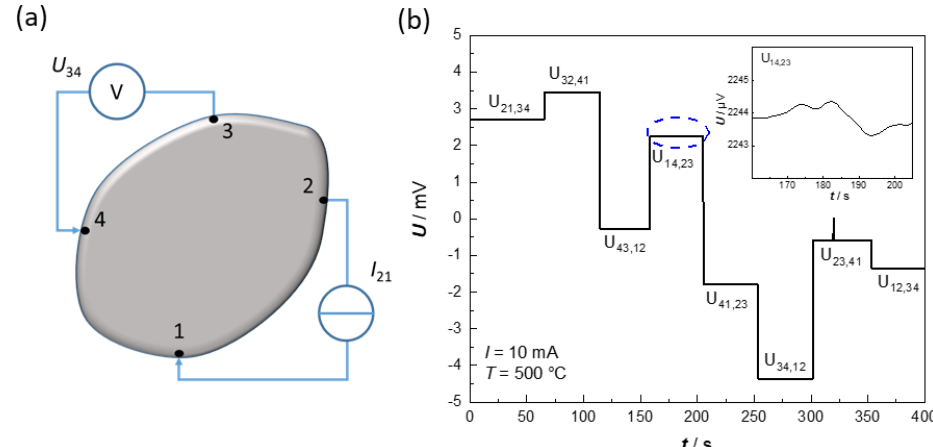
Figure 8. Measurement of the electrical conductivity. (a) Exemplary measurement configuration for the voltage U 21 , 34 . (b) Exemplary raw data of the measured voltages of a silicon wafer, to determine the electrical conductivity at 500 ◦ C, to investigate the influence of the heater.